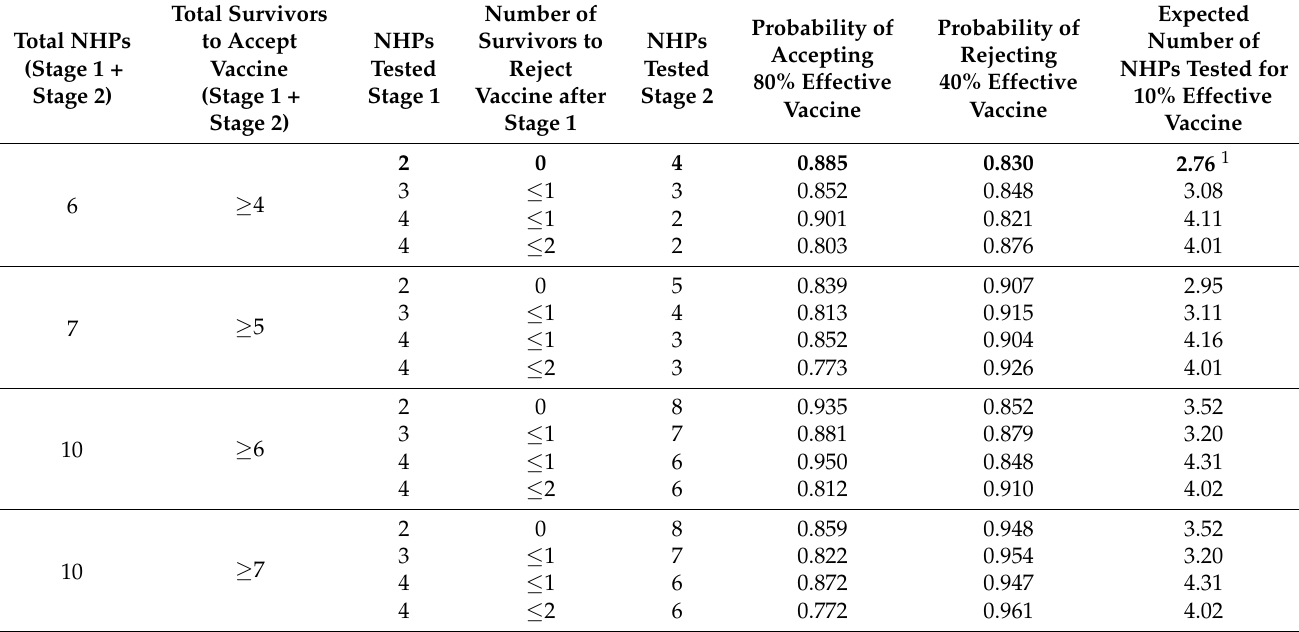
Table 1. Examples of two-stage screening designs that meet design objectives of greater than 80 percent probability of accepting an effective vaccine and greater than 80 percent probability of rejecting an ineffective